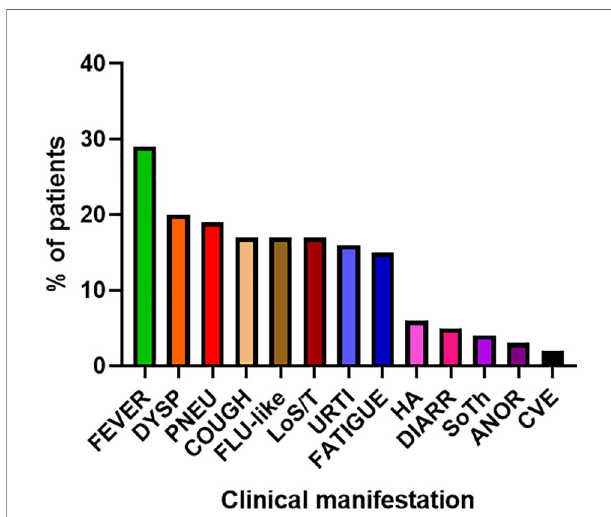
FIGURE 5 | Main clinical manifestations of COVID-19 in enrolled patients (n= 81) (DYSP, dyspnea; PNEU, pneumonia; LoS/T, loss of smell/taste; URTI, upper respiratory tract infections; HA, headache; DIARR, diarrhea; SoTh, sore throat; ANOR, Anorexia; CVE, cardiovascular